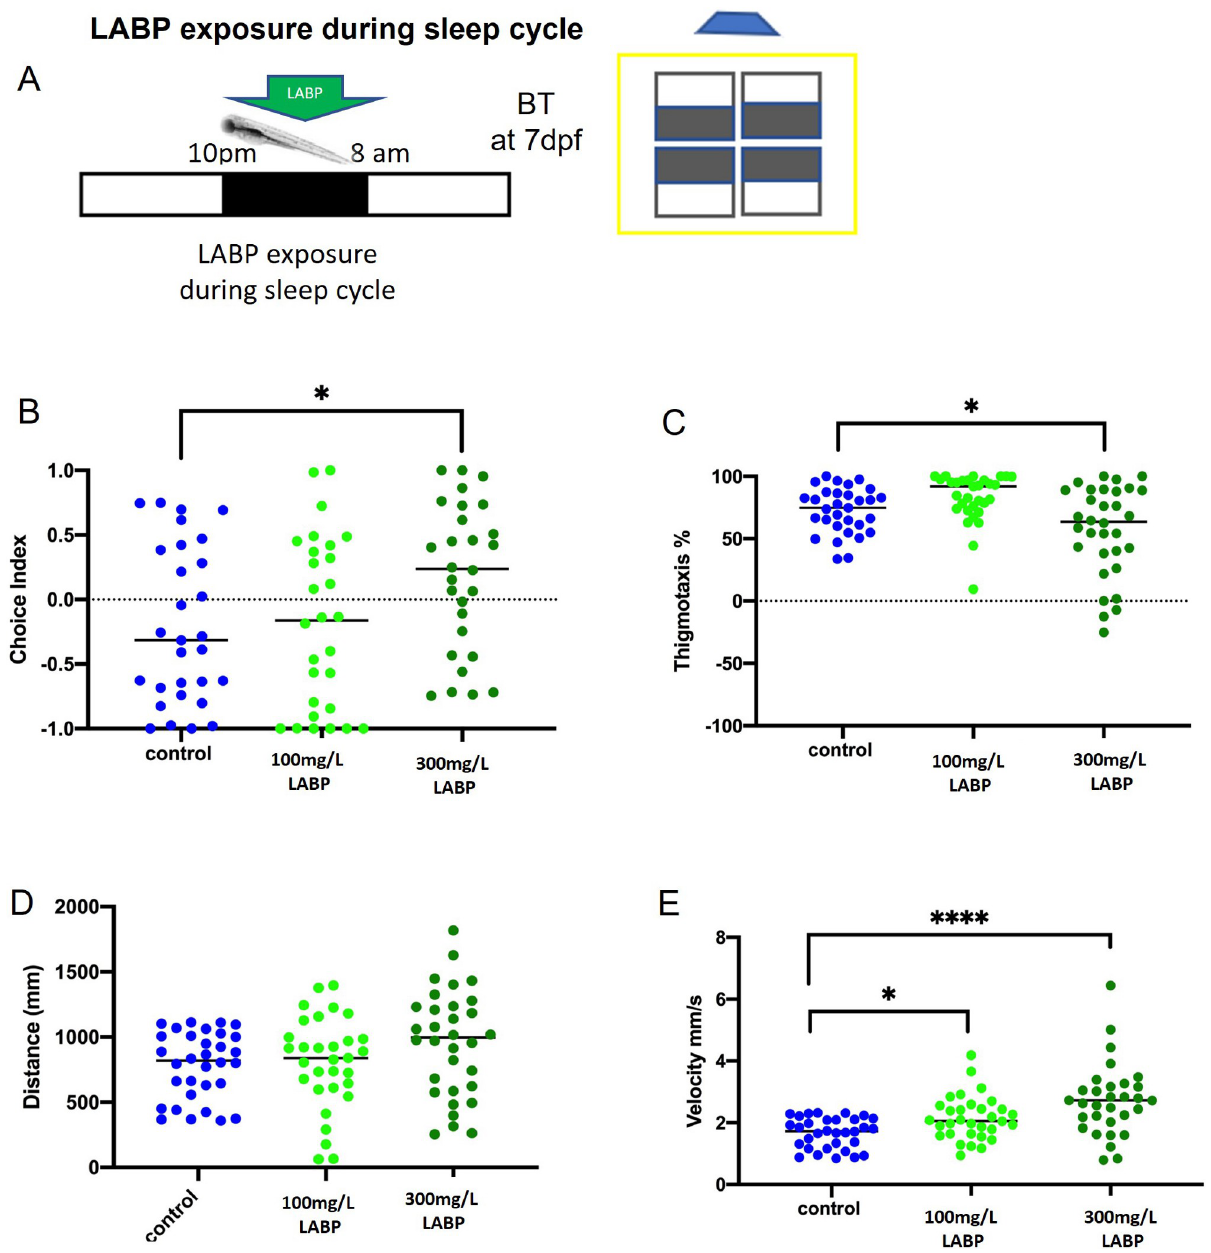
Fig 3. Behavior effects after LABP exposure during the sleep cycle. A. The schematic of the behavior test after LABP exposure during the sleep cycle. The larvae were kept on dark and LABP exposure from 10 pm-8 am. B. 300 mg/L LABP significantly increased the choice index when compared to control (p = 0.0410). C. Thigmotaxis significantly showed a reduction in the group treated with 300 mg/L LABP when compared to the control group (p = 0.0346). D. Distance was increased in 300 mg/L LABP but not significantly (p = 0.0870). E. LABP significantly increased velocity in both 100 and 300 mg/L concentrations (p = 0.0416; p < 0.0001). Asterisks indicate statistical differences between groups ( � p < 0.05, �� p < 0.01, ��� p < 0.001, ���� p < 0.0001). n =